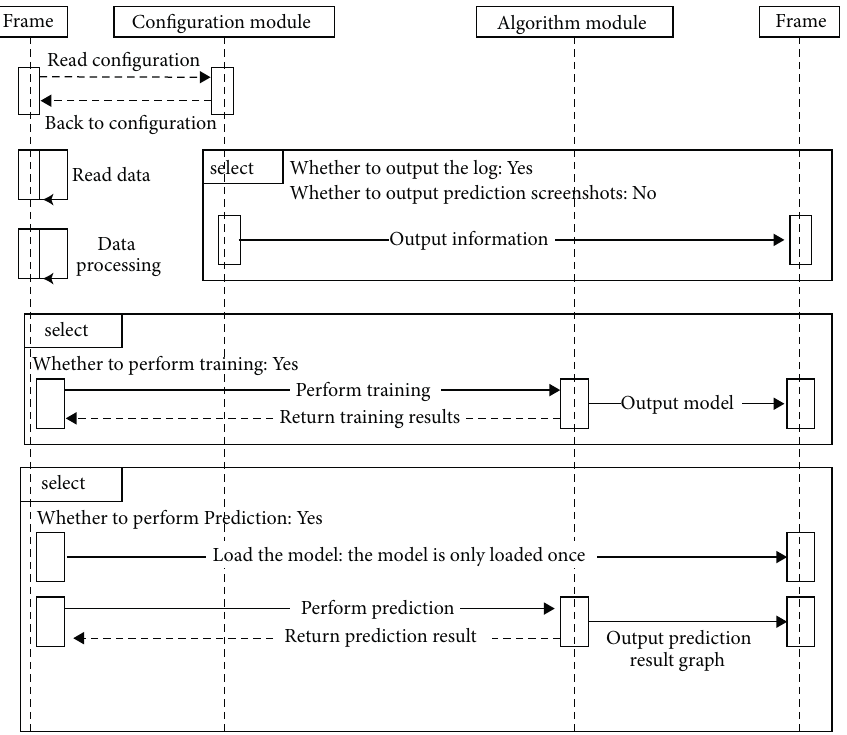
Figure 2: Bi-GRU-ATT model development framework